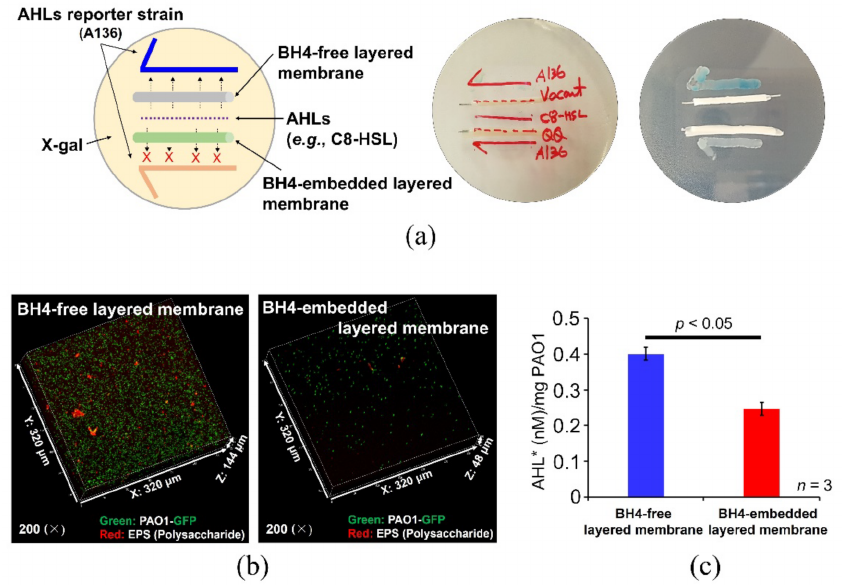
Figure 4. QQ activity and antibiofouling effects of the layered composite membranes. ( a ) AHL (e.g., C8-HSL) quenching by BH4 in the layered membrane. ( b ) CLSM images of BH4-free and BH4-containing layered membrane surfaces. The fluorescent dye, Concanavalin A, was used for staining. Polysaccharides are shown in red. The green color indicates the growth of GFP-tagged P. aeruginosa PAO1, a model strain for AHL QS bacterium. ( c ) Concentration of AHL* (3-oxo-C12-HSL) was detected from the surface of the two layered membranes ( n = 3). The error bars represent one standard deviation, and the p -value is derived from a two-tailed Student’s t